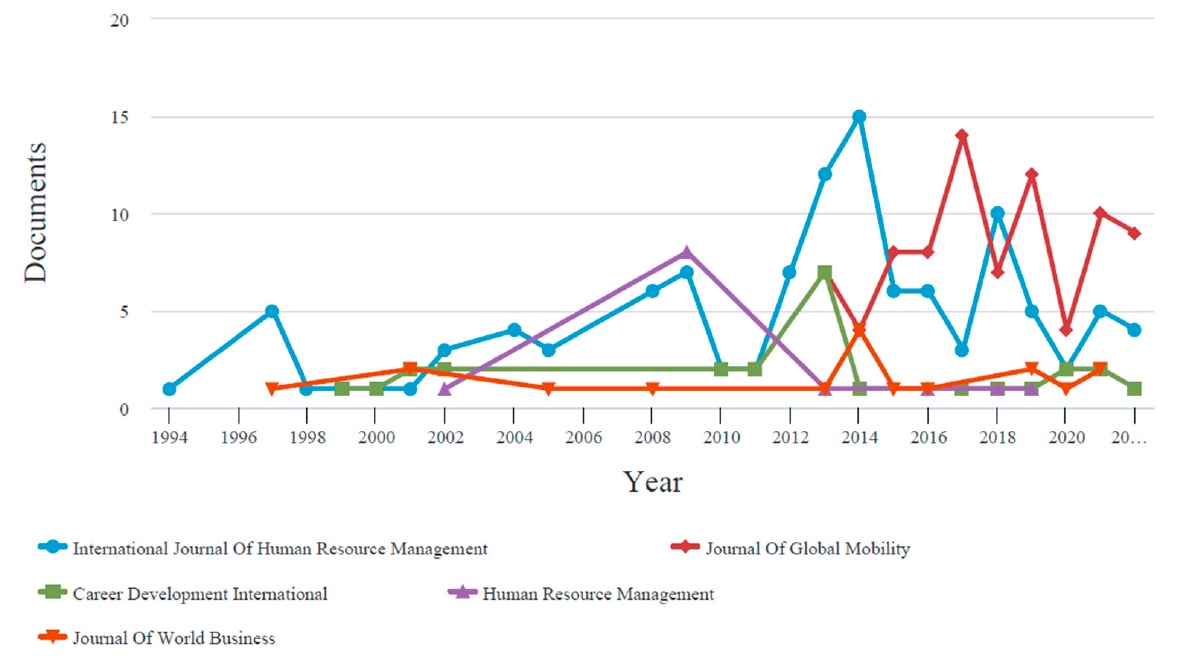
Figure 4. Expatriation documents per year by source. Source: Data obtained from Scopus (August 2022).